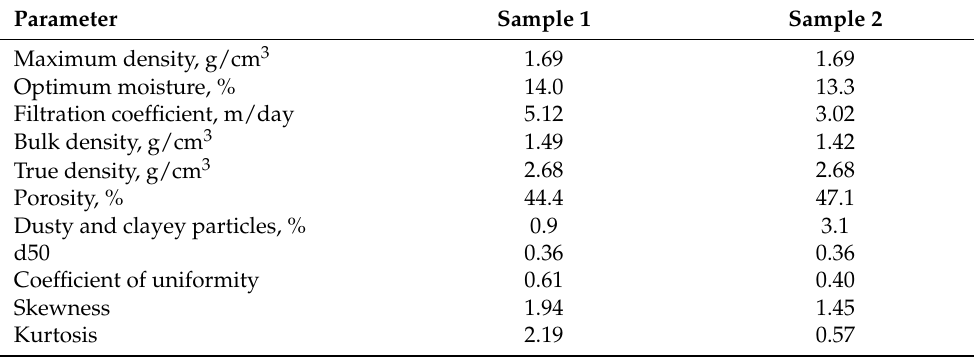
Table 1. Parameters of the sand samples used in measurements determined according to GOST 8735,